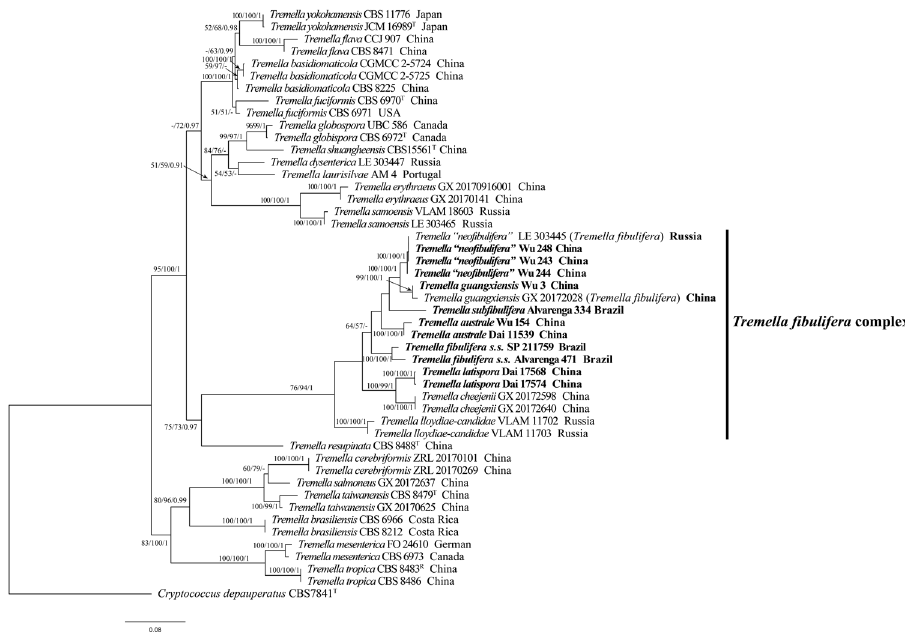
Figure 2. The Maximum likelihood tree showing phylogenetic relationship of species in Tremella s.s. based on the combined ITS + partial nLSU + mtSSU + TEF1 + RPB1 + RPB2 dataset. Bootstrap support values for MP and ML greater than 50% and BI greater than 0.95 are given at each node respectively. The samples used in this study are in